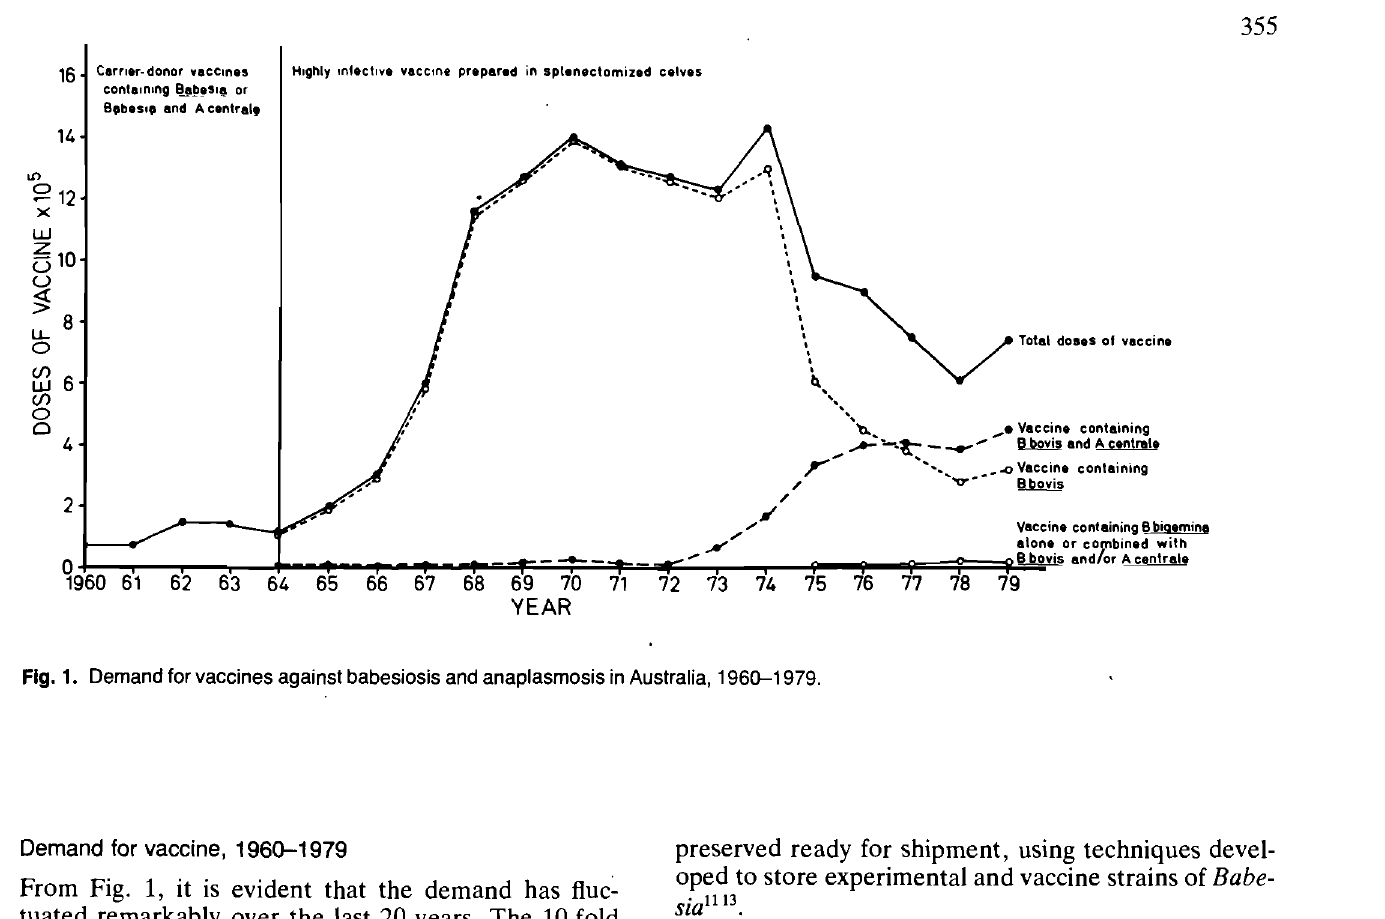
Fig. 1. Demand for vaccines against babesiosis and anaplasmosis in Australia, 1960--1979.